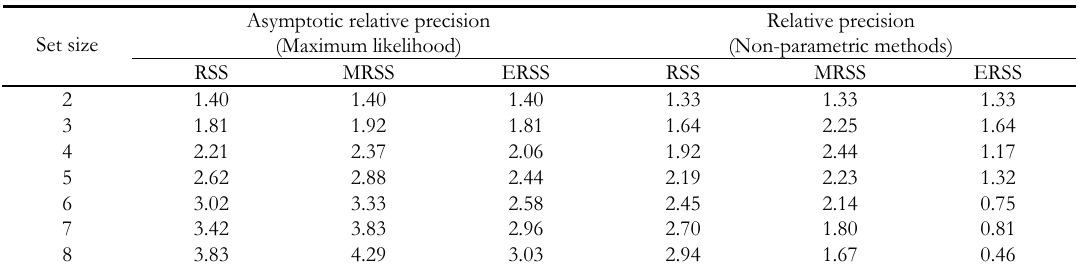
Relative precision (Non-parametric methods) Set size